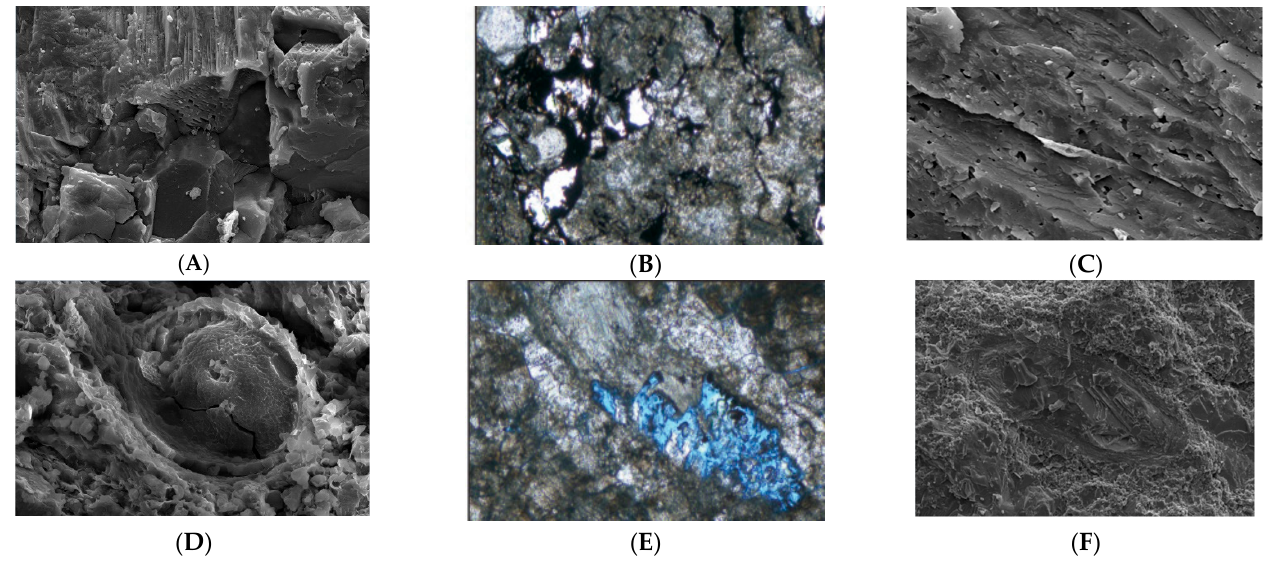
Figure 5. Microscopic slices of corrosion and biodetritus in Eastern Sichuan. ( A ) Intracrystalline corrosion holes of calcite in the first member of Maokou Formation. ( B ) Eyelid development intercrystalline corrosion pores and corrosion seams in the first member of Maokou Formation. ( C ) Development of intercrystalline pores in the first member of Maokou Formation. ( D ) Biodetritus and micro-fractures developed in the first member of Maokou Formation. ( E ) Development of intragranular corrosion pores of eyelid biodetritus in Maokou Formation. ( F ) Biodetritus filling in the first member of Maokou Formation.